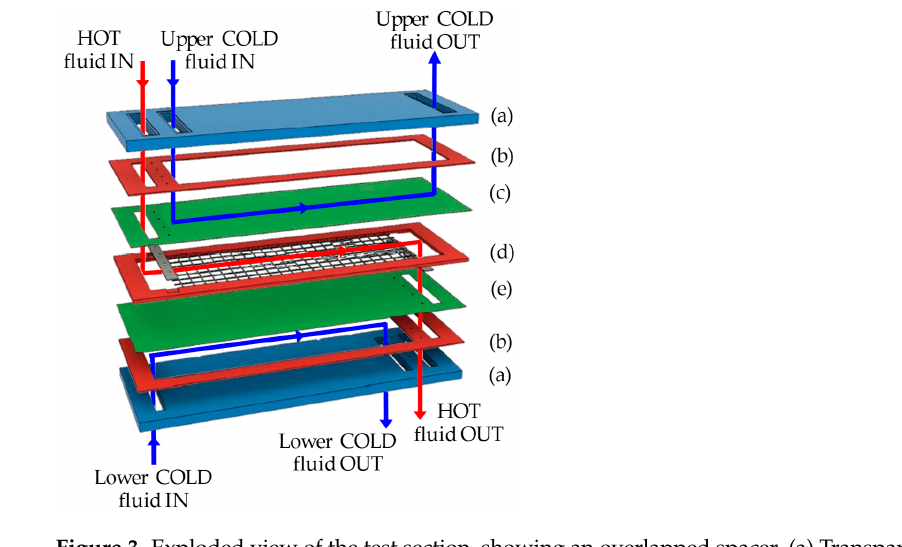
Figure 2. Photographs of the actual spacers tested, with their filaments oriented at 0–90° (top row) or at 45° (bottom row) with respect to the flow direction (arrow). ( a , d ) overlapped; ( b , e ) woven; ( c , f ) spheres. The pitch-to-height ratio P / H = 4 in all of the cases.